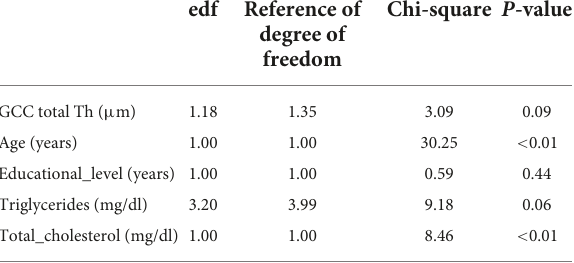
TABLE 5 Generalized additive model regression on the FIB-4 cut-off of ≥ 2.67 (fibrosis/no fibrosis) as dependent variable and regressors.